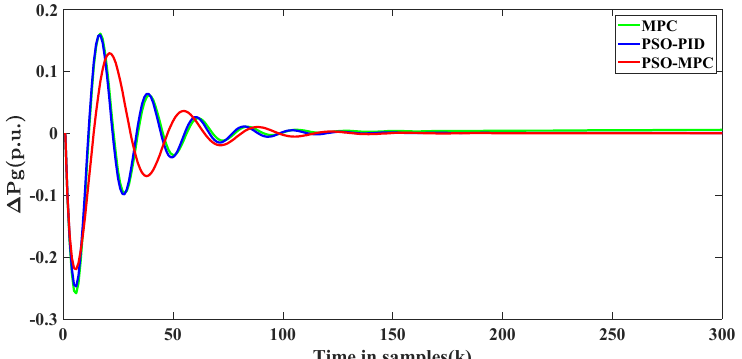
Figure 12. Output deviation signal of the governor ∆𝑃 (cid:3034) under the three strategies with wind tur-